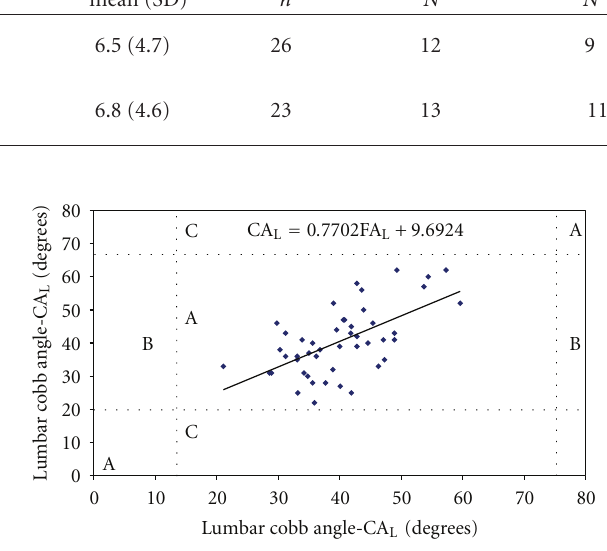
Table 2: X-ray and flexicurve measurements of the thoracic and lumbar curvature. Curvature